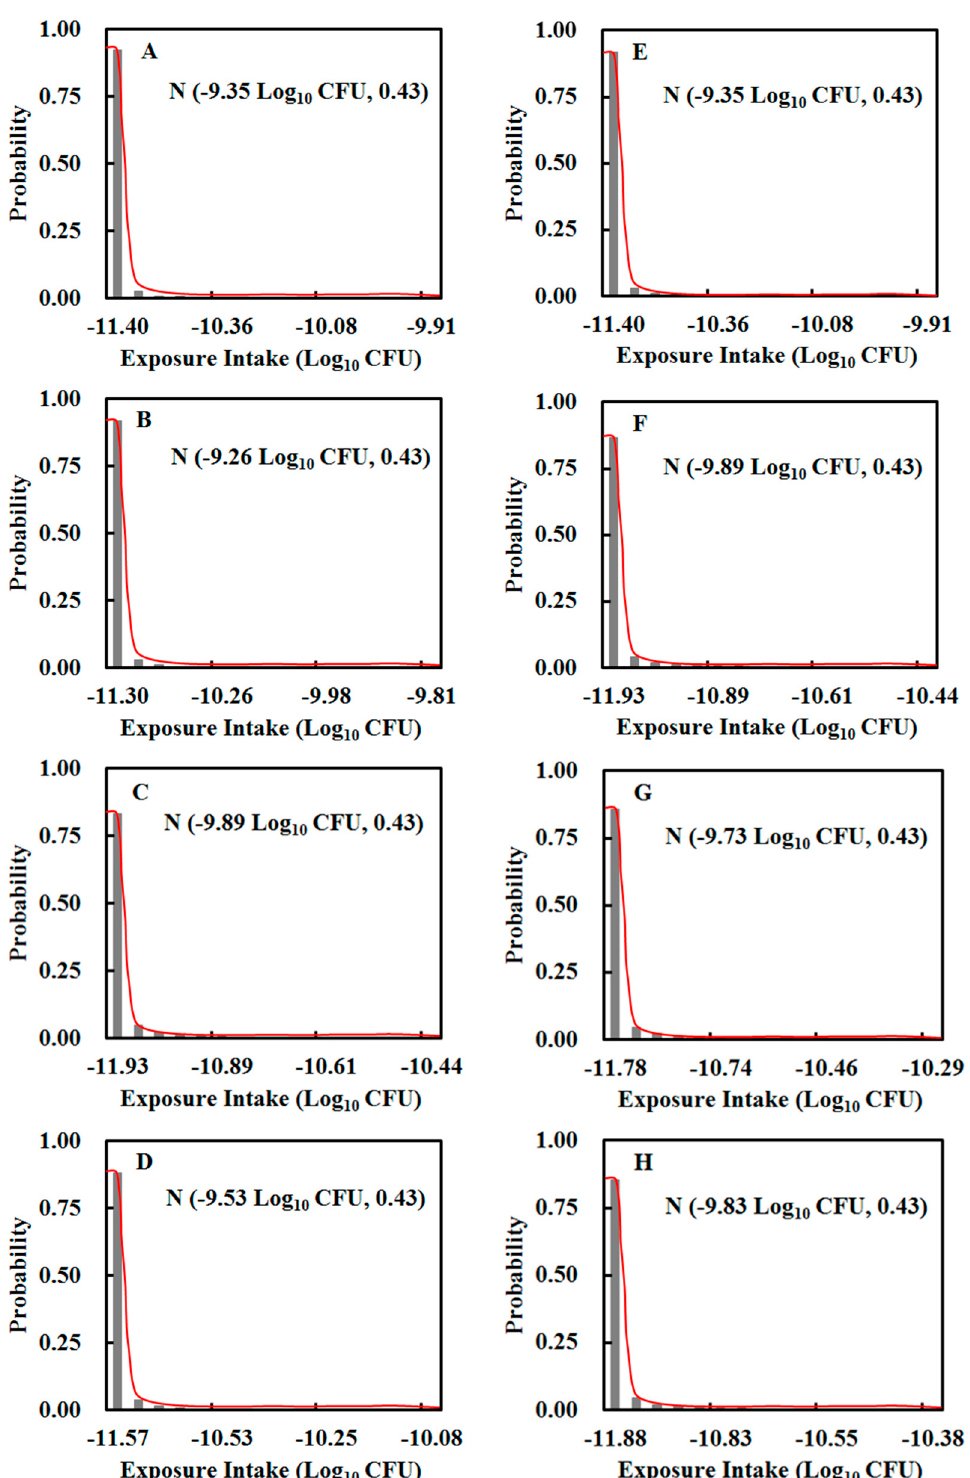
Figure A3. The probability distribution of ingesting E. coli O157:H7 among the Taiwanese population for each sex and age group from consuming medium well beef imported from the USA. ( A ) Males and females aged 4–12 years, ( B ) males aged 13–18 years, ( C ) females aged 13–18 years, ( D ) males aged 19–65 years, ( E ) females aged 19–65 years, ( F ) males aged > 65 years, ( G ) females aged > 65 years, and ( H ) females aged 19-49 years (of childbearing age). 417 Table A1. Summary of the parameters. 418 Variable Description Distributional assumption